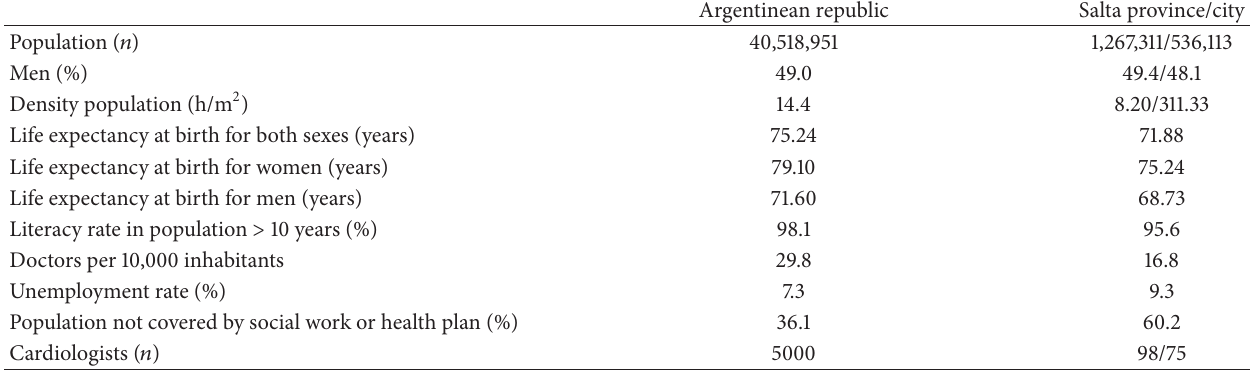
Table 1: General demographic indicators in Argentinean and Salta populations